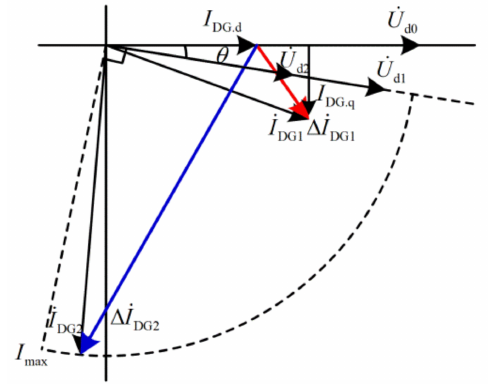
Figure 4. The phase relationship between the output current of the IBDG and the voltage of the grid-connected